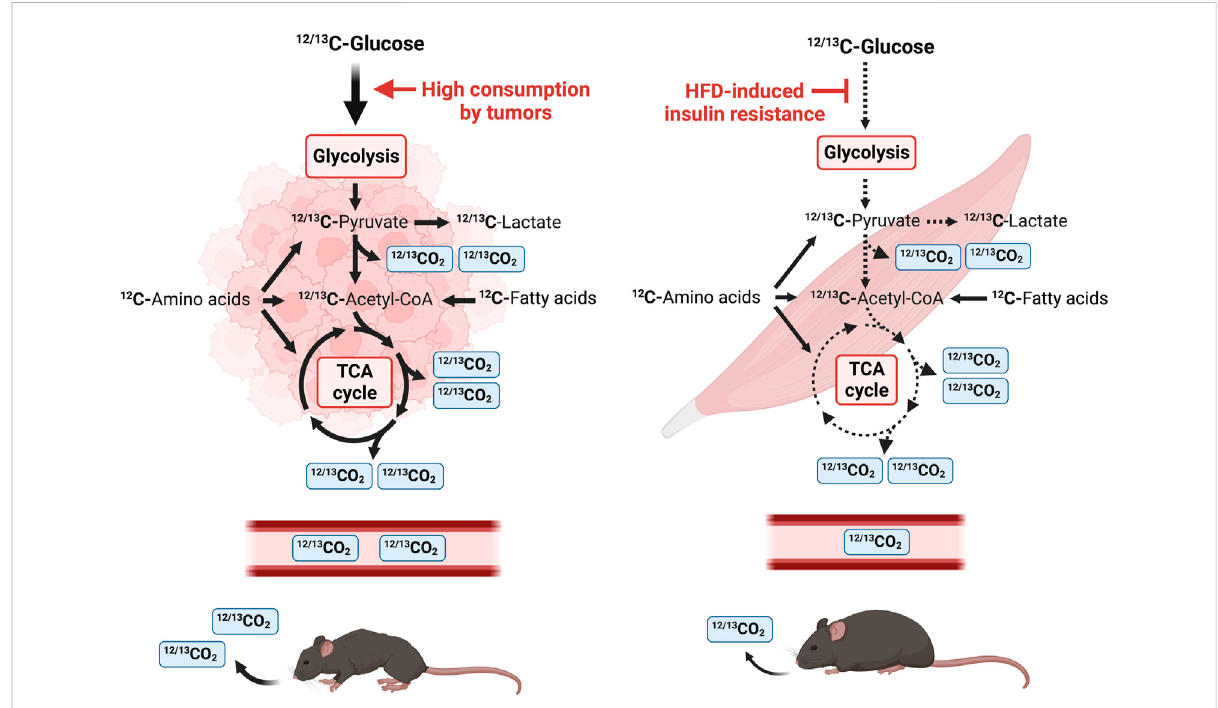
FIGURE 1 Schematic diagram of a stable isotope breath test study in mice using U- 13 C glucose. U- 13 C glucose tracer is introduced by intraperitoneal injection and the amount of 13 CO 2 and total CO 2 ismeasured by a nondispersive infrared spectrometer.Tumor tissue consumes a mix of 12 C and 13 C glucosethatismetabolizedthroughglycolysis. 13 C-pyruvate,theend-productofglycolysis,iseitherconvertedto 13 C-lactateorenterstheTCAcycle in the mitochondria. One CO 2 is released from pyruvate oxidation to acetyl-CoA and two CO 2 molecules are released per round of the TCA cycle. Tumors heavily consume glucose and tumor-bearing mice release a larger amount of 12 CO 2 and 13 CO 2 in the air. In contrast, HFD-induced IR leads to a reduction in systemic glucose uptake and utilization, and this is re fl ected in a reduction of expired 12 CO 2 and 13 CO 2